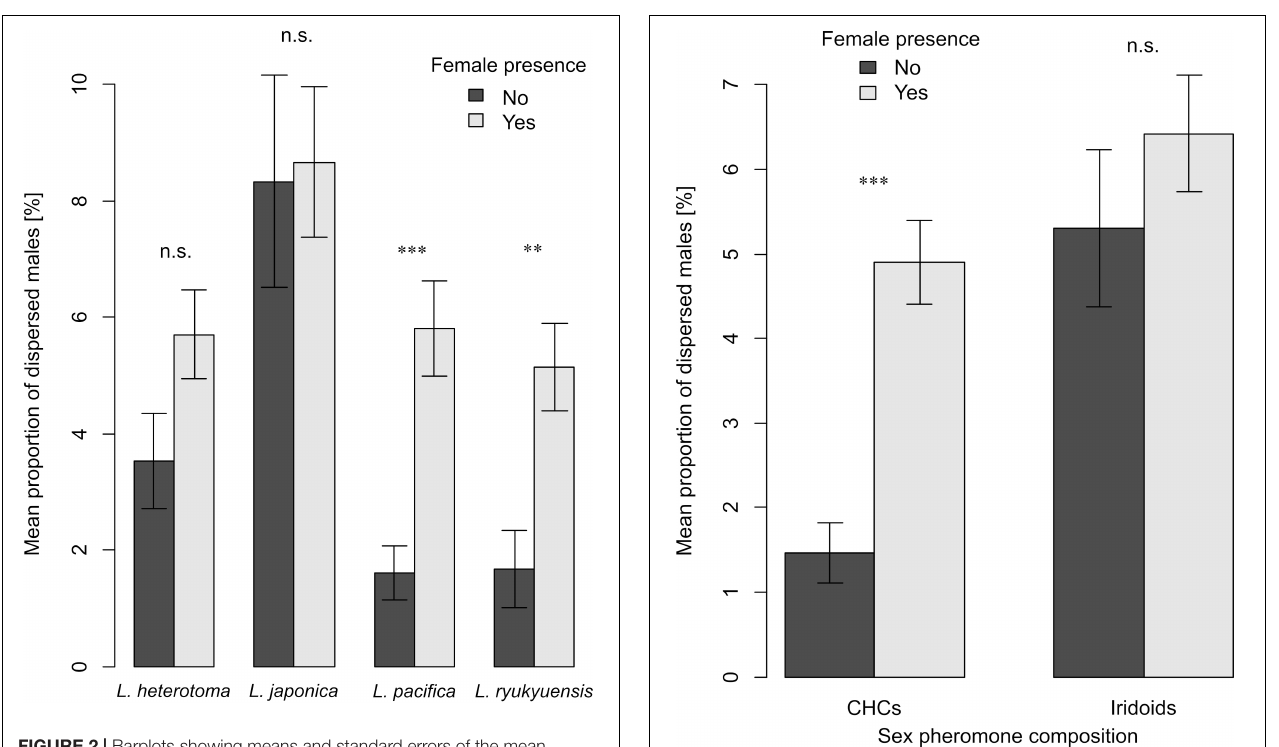
FIGURE 2 | Barplots showing means and standard errors of the mean proportions of dispersed males within the 48 h before (dark gray bars) and within the 48 h after (light gray bars) female emergence in each jar for L. heterotoma , L. japonica , L. pacifica , and L. ryukyuensis . Dispersal before and after female emergence was compared with Wilcoxon signed rank tests (Bonferroni corrected). Asterisks indicate a significant difference ** P < 0.01, *** P < 0.001, n.s. not significant. For each experiment, N = 30.